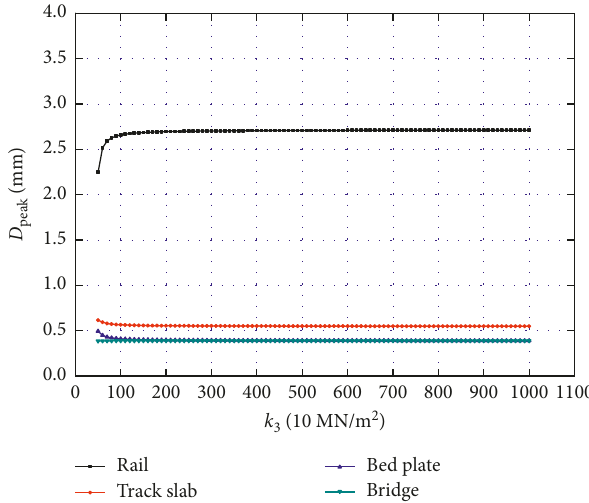
Figure 6: The maximum dynamic deflections of the rail, track plate, base plate, and bridge corresponding to different stiffnesses of the fastener under the rail.